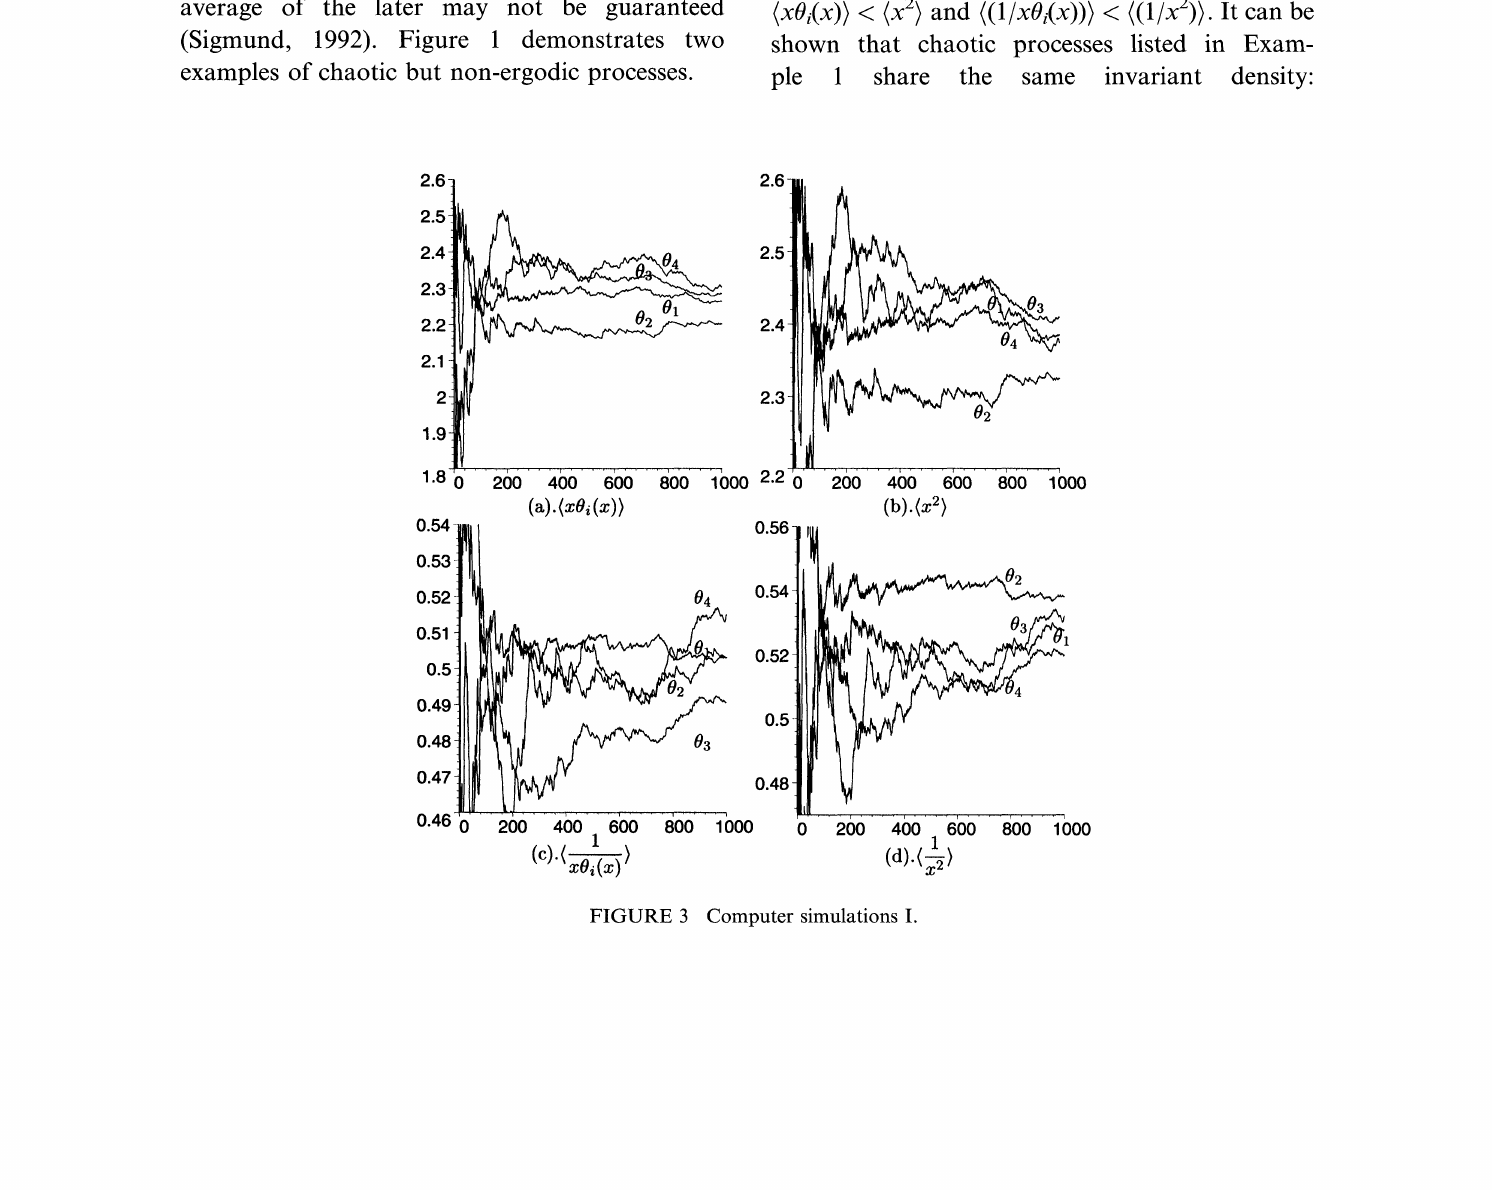
FIGURE 3 Computer simulations